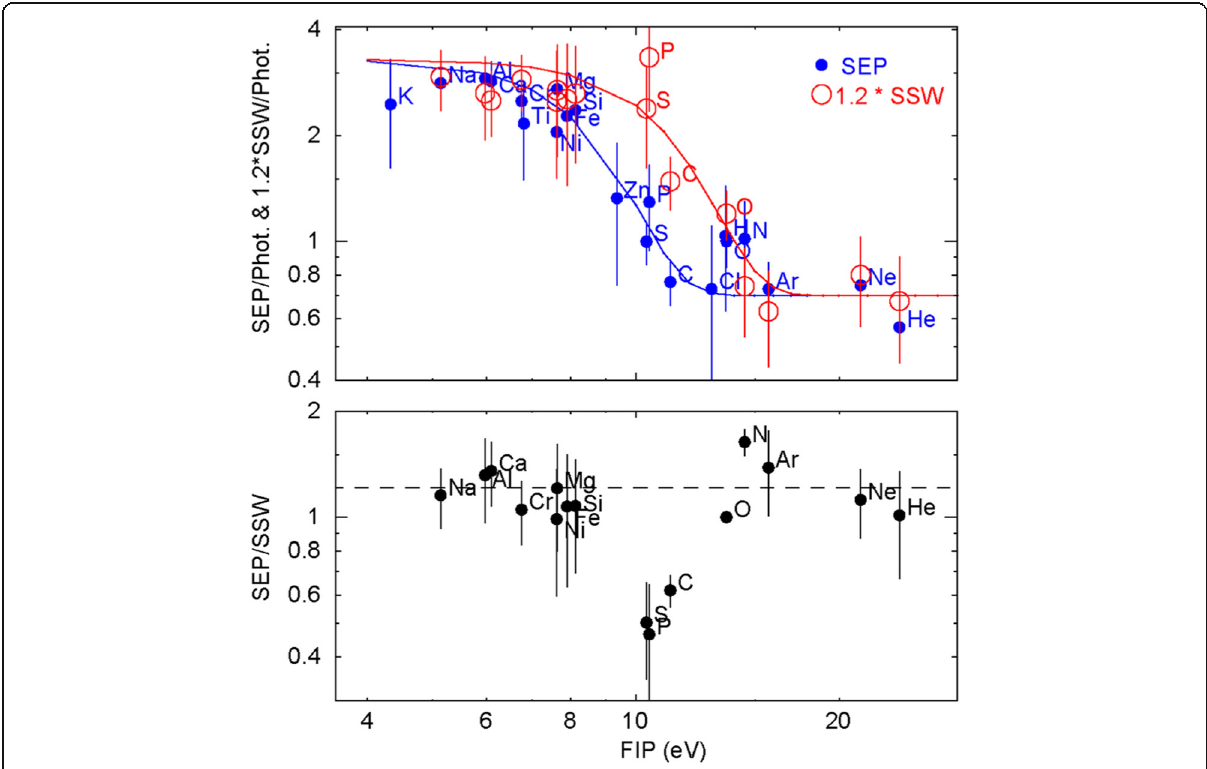
Fig. 24 The upper panel shows the SEP/photospheric and 1.2xslow solar wind (SSW)/photospheric abundance ratios as a function of FIP. Curves help show the trends of each data set. The lower panel shows the ratio of the “ coronal ” abundances from SEPs to those of the slow SW (Bochsler 2008), as a function of FIP. The dashed line suggests the preferred normalization factor of 1.2. Adopted from Reames